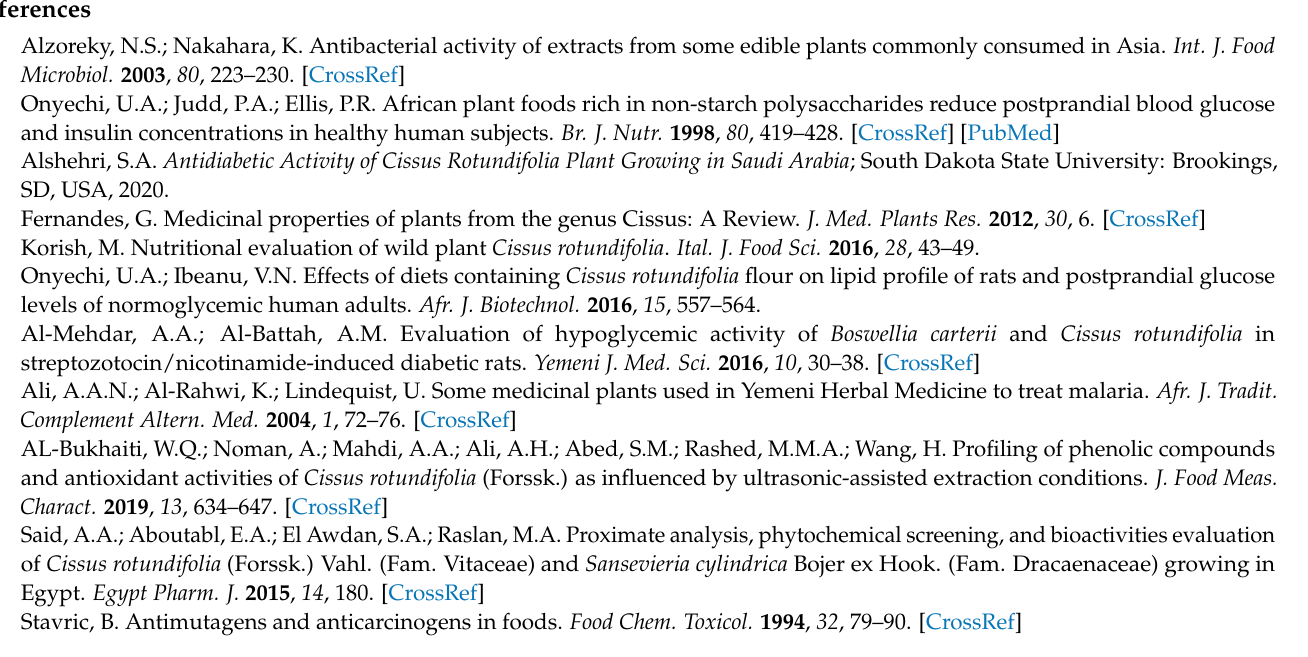
molecular function, and biological process). The left y-axis represents the gene percentage while the right y-axis indicates the number of genes in the categories. (b) COG terms. The genes were classified into 25 functional categories. The letters represent respective functional categories, Figure S4: RNA-seq validation by qPCR. The histograms indicate the qPCR results for 12 selected genes involved in flavonoid biosynthesis in 3 organs of C. rotundifolia . The error bars represent the mean SD of three biological replicates, Figure S5: Transcription factors expression profile. The expression major transcription factor families involved in flavonoid biosynthesis were analysed. (a) bHLH